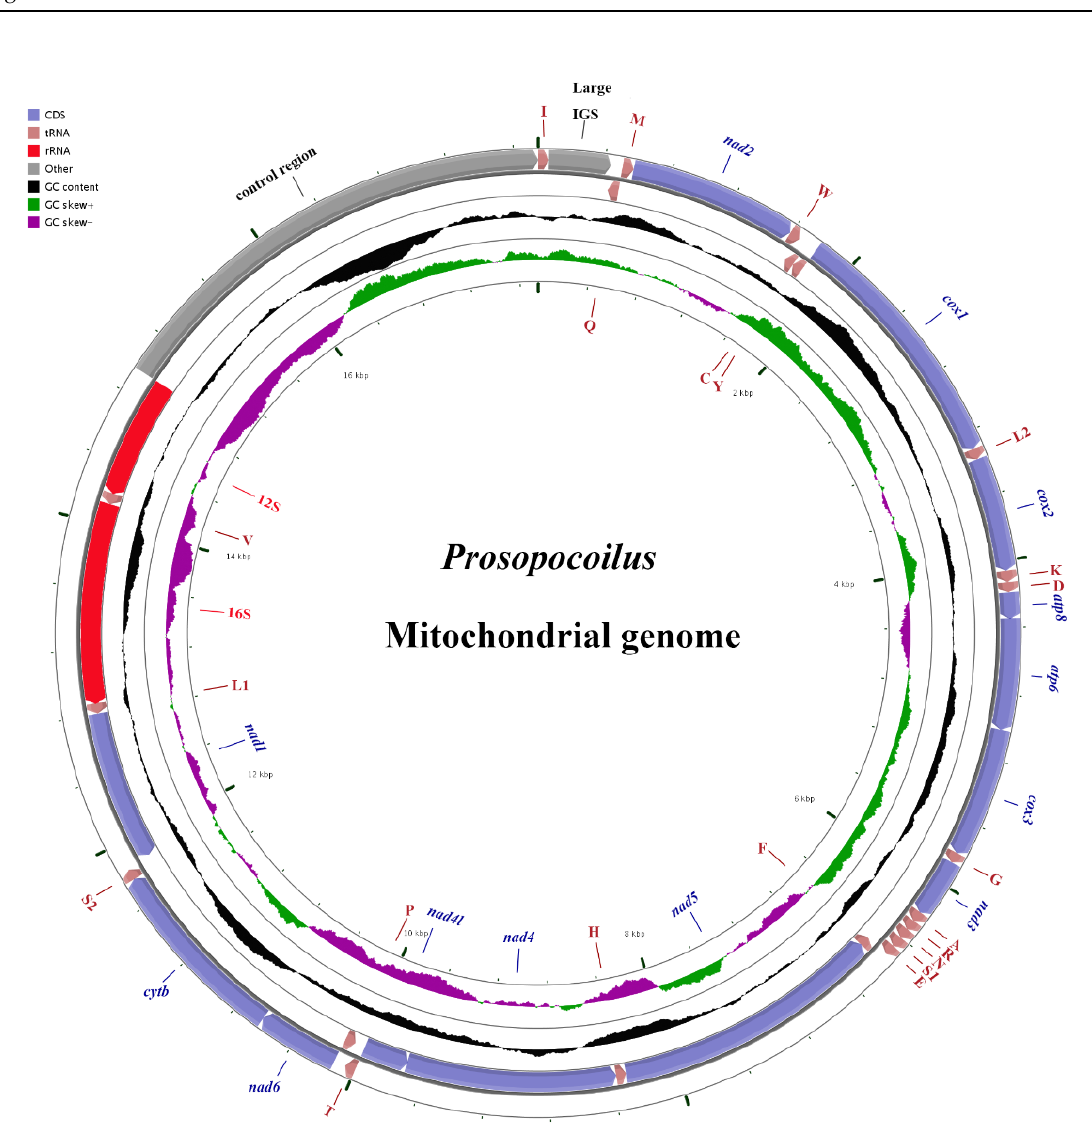
Figure 1. The mitochondrial genome map of Prosopocoilus species. The names of PCGs and rRNA genes are indicated using standard abbreviations, whereas the names of tRNA genes are indicated using single-letter abbreviations. The first circle shows the gene arrangement, and arrows indicate the direction of gene transcription. Blue, red, pink, and grey arrows indicate PCGs, rRNA genes, tRNA genes, and the control region, respectively. The second circle indicates the GC content, and the third circle indicates the GC-skew. The innermost circle indicates the size of the